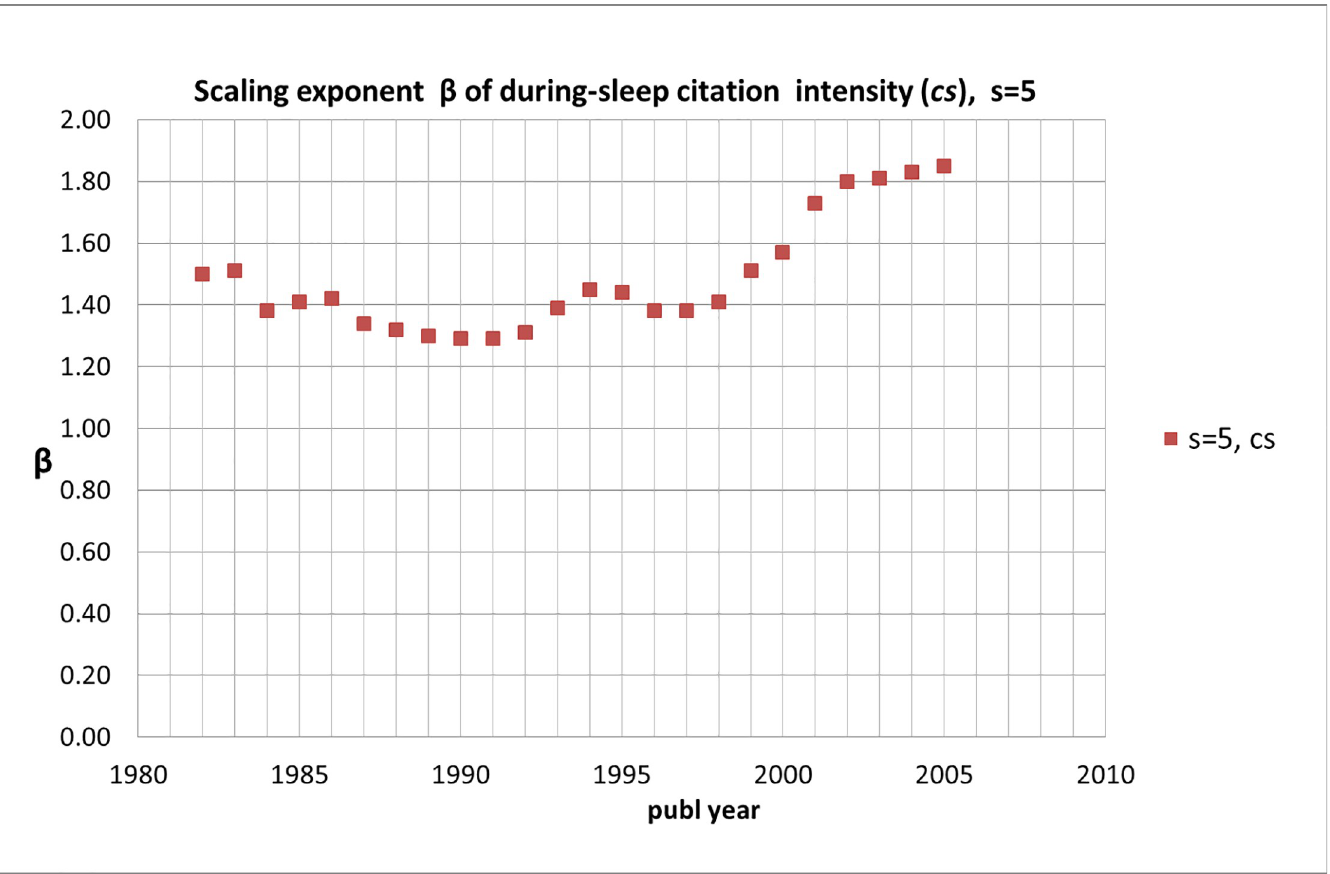
Fig 9. Scaling exponent β of during-sleep citation intensity, SB-SNPRs with s = 5; numbers are the averages of successive five-years blocks, each five-years block is located in the figure by its middle year.